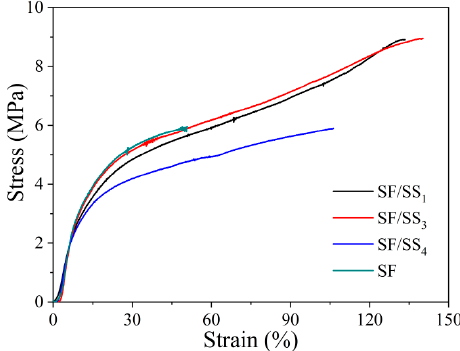
Figure 6. Stress-strain curves of SF/SS composite films.